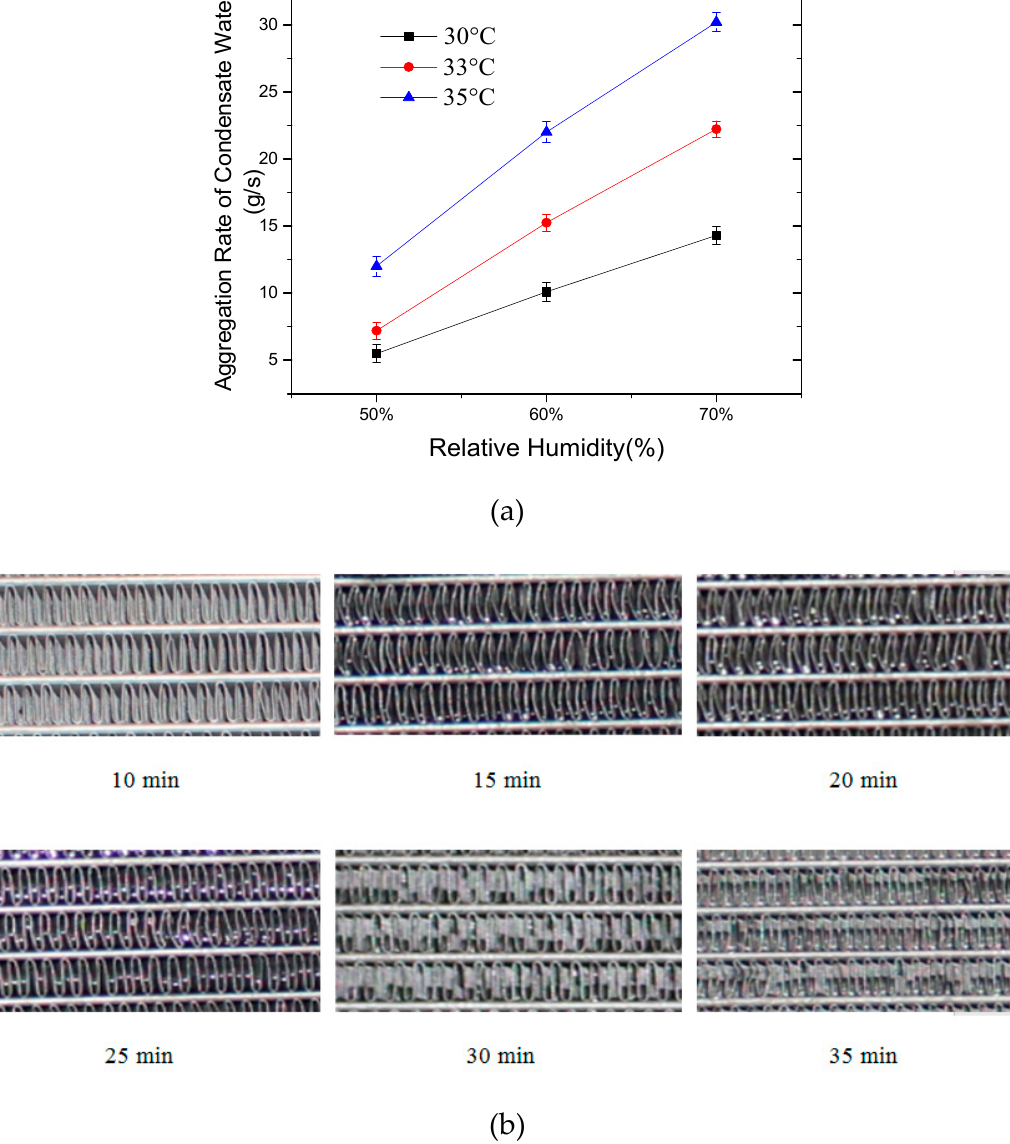
Figure 7. Variation in aggregation rate under different working conditions and Variation in condensate aggregation over time: ( a ). Condensate aggregation rate under different temperatures and relative humidities; ( b ). Pictures of the condensate aggregation map at a temperature of 30 ◦ C and relative humidity of 50%.